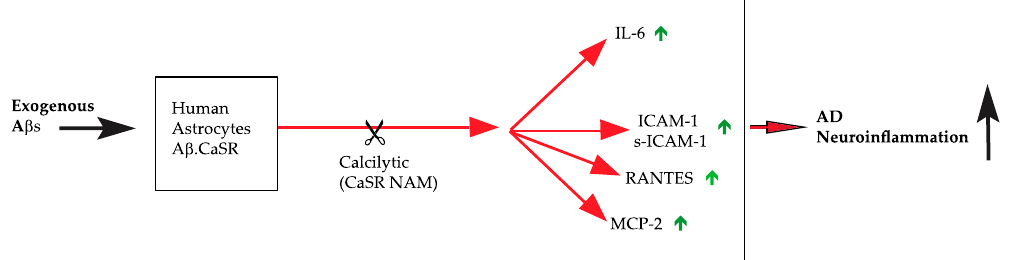
Figure 5. Synopsis of the direct pro-neuroinflammatory effects pathological A β •CaSR signaling evokes in NAHAs. The administration of a CaSR negative allosteric modulators (NAM) nearly